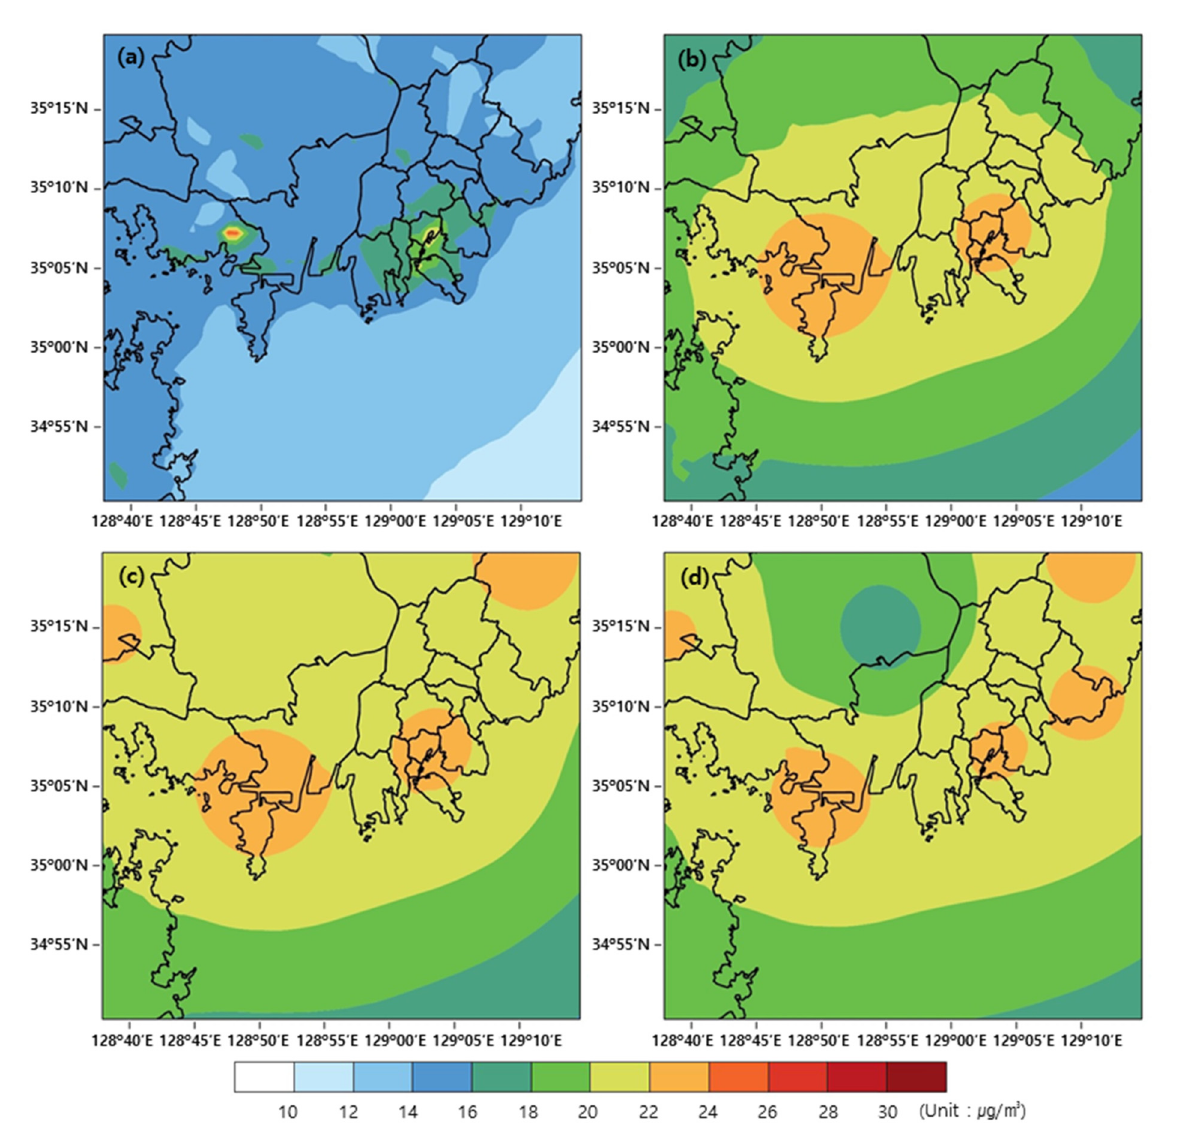
Figure 11. Monthly average spatial distribution diagram of air pollutants by ( a ) CMAQ model and ( b ) Hybrid model with 2 sites, ( c ) with 4 sites, ( d ) with 6 sites.